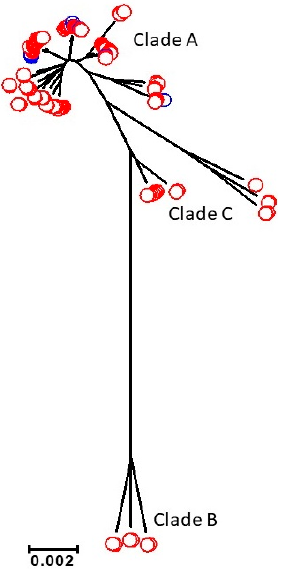
Figure 1. Population structure of 115 S. epidermidis isolates constructed from 522 core genes and implemented in MEGA6. Isolates are coloured according to source: PJI (red) and FRI (blue). The scale (0.002) is in coalescent units and represents the number of substitutions per site.